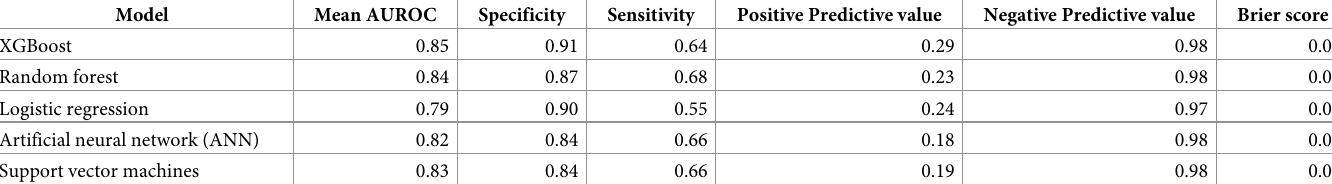
Table 4. Performance metrics of final calibrated models when evaluated against the hold-out set (n = 827). Model